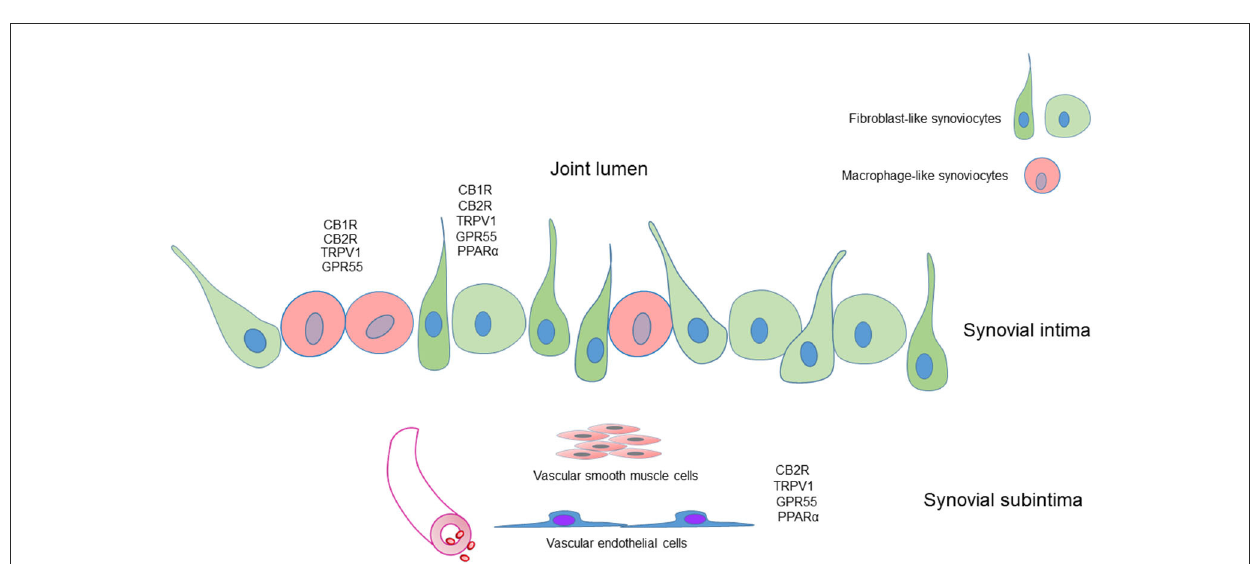
FIGURE10 Graphical representation of the distribution of the cannabinoid receptors 1 (CB1R) and 2 (CB2R) and the cannabinoid-related receptors transient receptor potential vanilloid 1 (TRPV1), G protein-coupled receptor 55 (GPR55) and nuclear peroxisome proliferator-activated receptor alpha (PPAR α ) in the different cellular elements of the synovial membrane of the equine metacarpophalangeal joint. Fibroblast-like synoviocytes (FLS), identified with an anti-vimentin antibody, expressed CB1R, CB2R, TRPV1, GPR55, and PPAR α immunoreactivity. Macrophage-like synoviocytes (MLS), identified with an anti-IBA1 antibody, expressed CB1R, CB2R, TRPV1, and GPR55